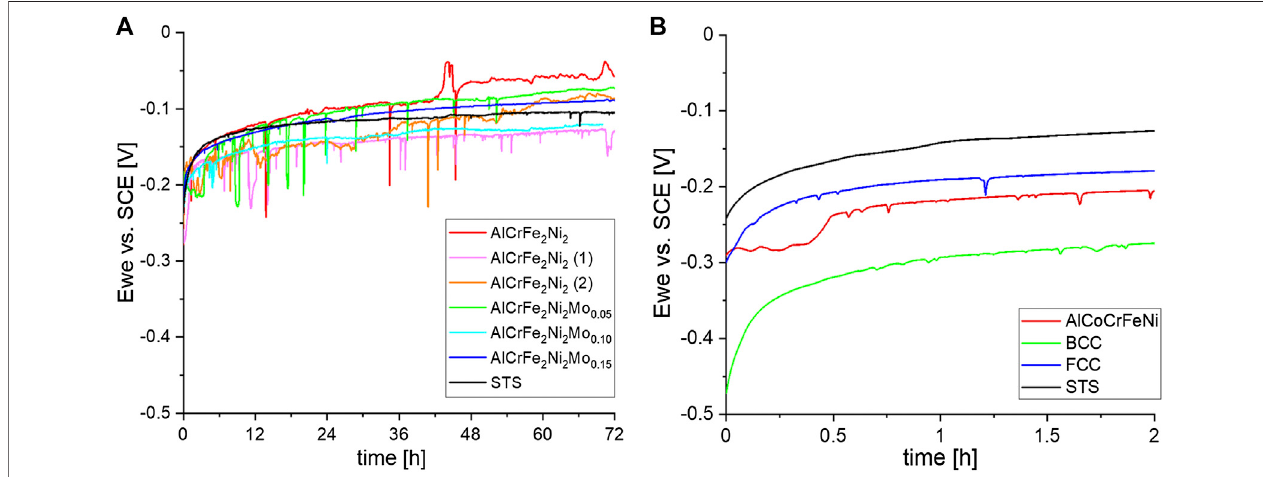
FIGURE 5 | Open circuit voltage evolution over time in 3.5 wt.% NaCl for the Co-free alloys and stainless steel (STS) (A) , and for three quinary alloys and STS (B) .